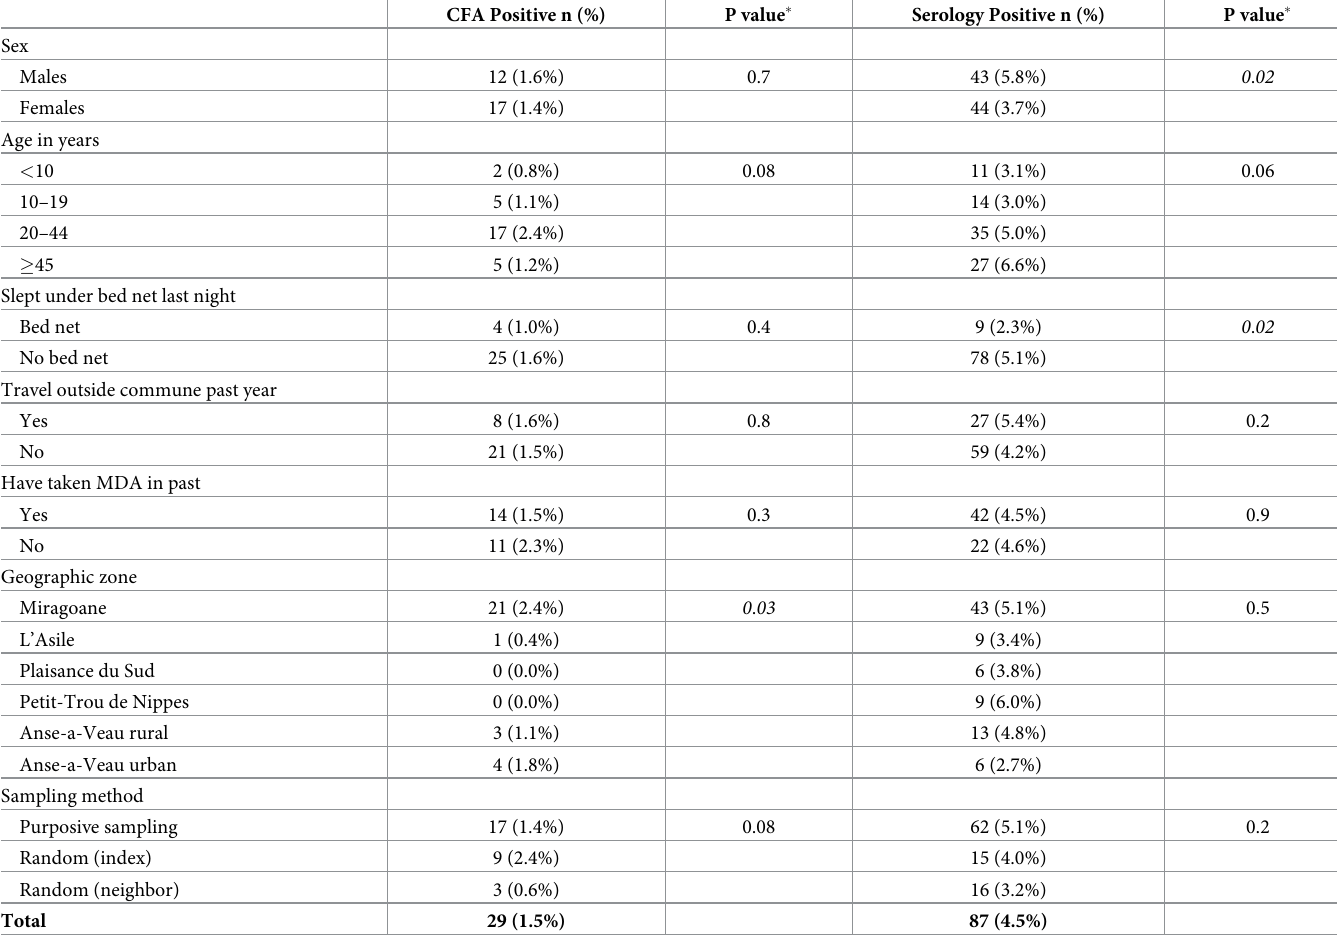
Table 2. Filariasis test strip (FTS) and serology results by participant characteristic, Nippes Department, Haiti, July-August 2019. FTS N = 1927; Serology N =